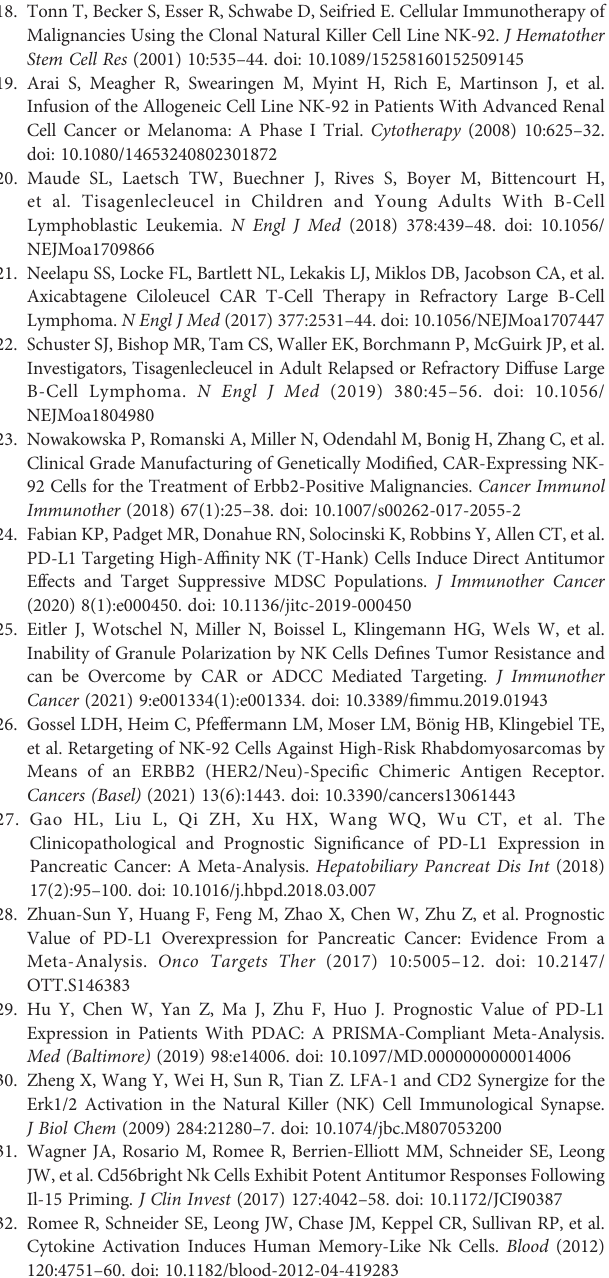
Supplementary Figure 4 | Visual and dynamical observation of the delivery process of secretory lysosomes of NK92 cells to PD-L1 high MP cells. From left to rightaretheimagesfrom12sequentialtimepointsoftheeffect-targetcellco-culture experiment. From top to bottom, the fi rst row indicates fi elds of view under the green fl uorescence(FITC)channel,thesecondrowindicates fi eldsofviewunderthe red fl uorescence (Cy5) channel, and the third row shows the overlay of the two- fl uorescence signals. Dynamically changes can be observed following the co- culture of effector and target cells, and the red box indicates typical degranulation phenomenon, in which NK92 cells delivered secretory lysosomes labeled by Lyso- Tracker Red fl uorescent probe to PD-L1 high MP